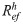
Estimation of Model SIR in Period 4 (October/2008—September/2012).(a) observed incidence (O) and adjusted i (E), (b) m3/m, (c) Refh (h) and Refm (m), and (d) Ref=Refh×Refm.